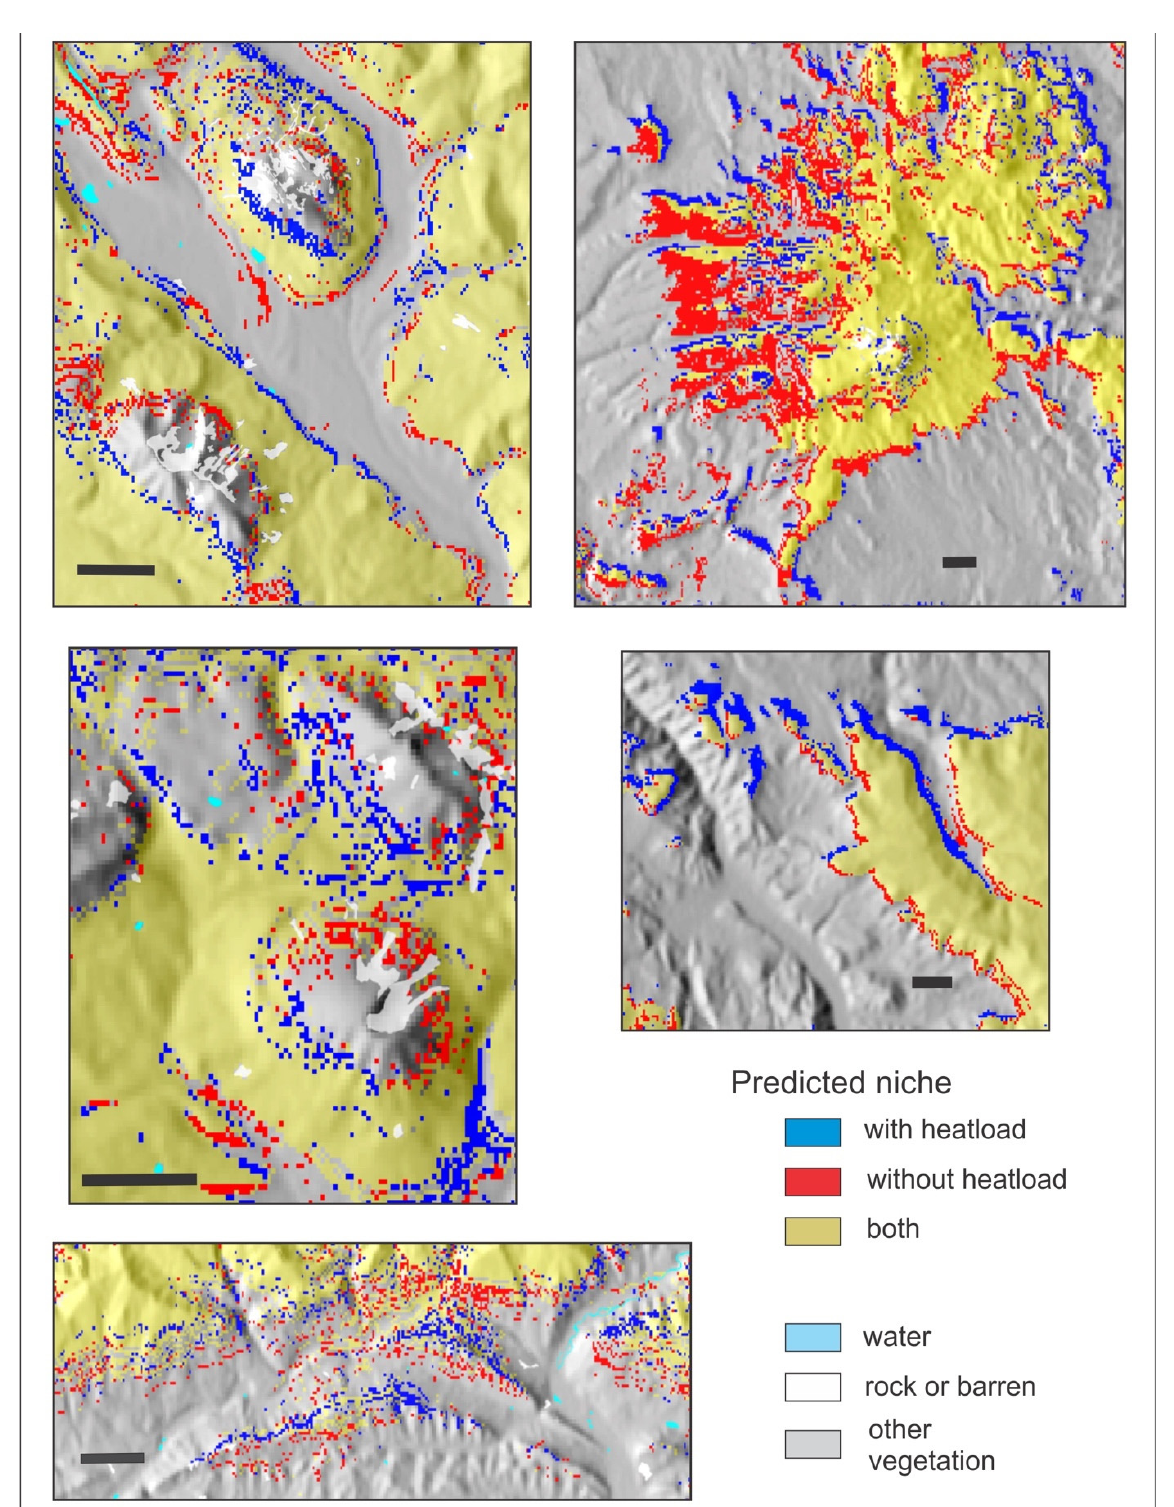
Figure A5. Reference period predicted niche of Populus tremuloides from two random forests classification trees illustrating the effects of heatload as a predictor. Gold, niche predicted by both models; red, predicted by 11 climate variables; blue, predicted by the climate variables plus heatload. Scale bar in each panel is 2 km.